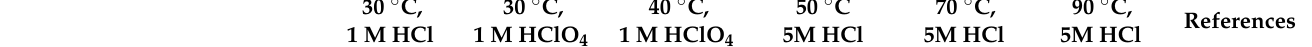
Table 3. Cont. Ligand Pseudo-First Order Half-Life for Decomplexation at Various